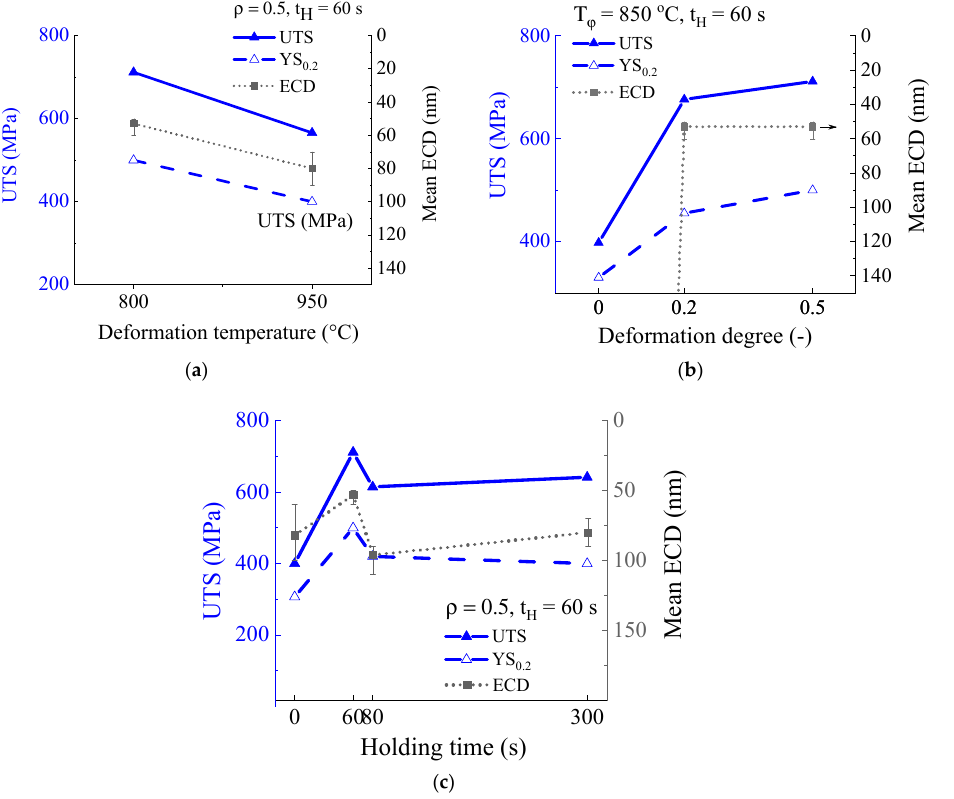
Figure 10. Impact of TMP parameters on ambient-temperature ultimate tensile strength and mean ECD of the Laves-phase particles: ( a ) φ = 0.5/t H = 60 s, ( b ) T φ = 800 °C/t H = 60 s, ( c ) T φ = 800 °C/ φ = 0.5. On the other hand, the ambient-temperature ductility of TMP HiperFer steel presents a negative correlation to the area fraction of Laves-phase particles. Figure 11 displays the evolution of tensile elongation of the TMP material. The tensile ductility obviously dropped with increasing Laves-phase particle area fraction. This was caused by the high hardness and brittleness of the Laves phase. Increasing the area fraction of a brittle phase decreases the ductility of the ferritic alloy matrix [37,38].